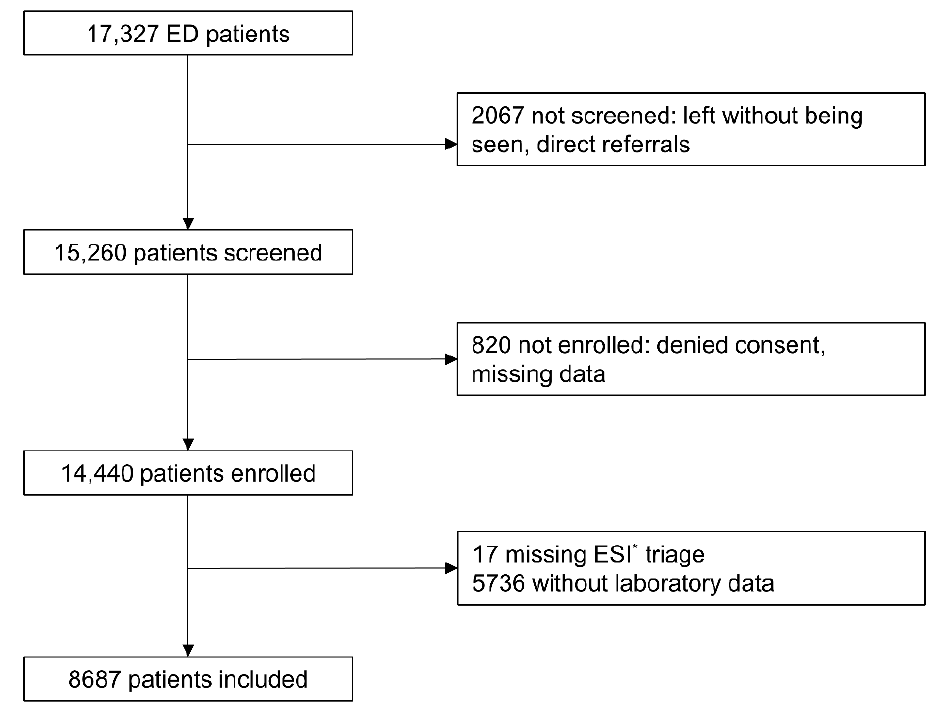
Figure 1. Inclusion procedure. ED: Emergency Department; * ESI = Emergency Severity Index. Their median age was 61 years (IQR 42–78 years) and 51.5% were male. Most were classified as ESI 3 (51.7%) and ESI 2 (37.3%). In addition, 183 patients died in hospital (2.1%), 4623 patients were hospitalized (53.2%), and 758 patients (8.7%) received ICU care. Patients without laboratory data were younger, had lower acuity ESI levels, and better outcomes (see Table